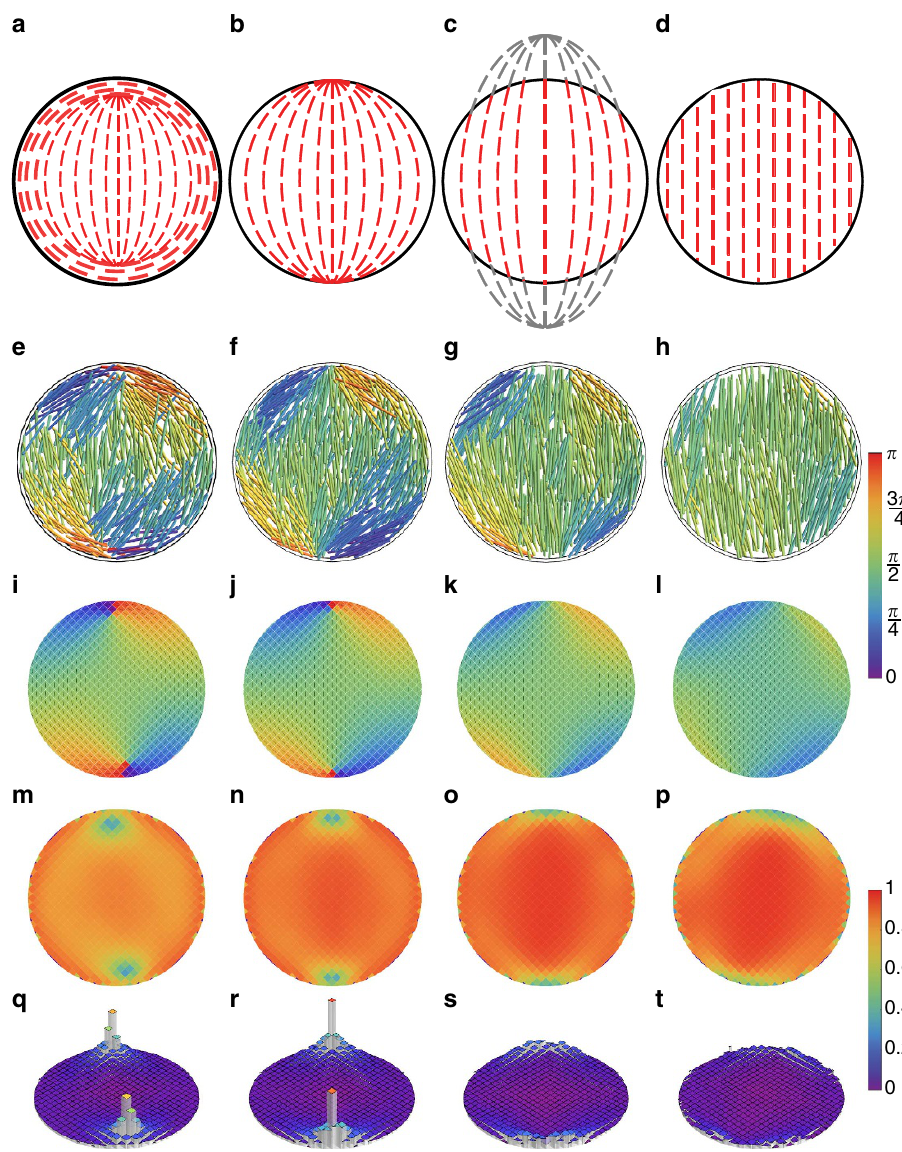
Figure 1 | Patterns of rod-like particles in circular confinement. Overview of packing structures of rod-like particles confined in shallow chambers with a circular geometry. Top row: schematic showing classification by the location of the disclination points: ( a ) type B i , ( b ) type B b , ( c ) type B o , ( d ) type B N . Second row: snapshots showing particle positions and their orientations with respect to the vertical (mod p ) (see colour bar on the right). Third row: orientation patterns averaged over 4 10 3 configurations. Fourth row: value of the scalar order parameter S A [0,1], scale bar on the right. For a discussion of the error estimate in this quantity see the Supplementary Note 8 and Supplementary Fig. 10 Note the characteristic dips at the location of the defects. Fifth row: normalized angular deficit parameter, which peaks at the centre of the defects. Simulation parameters: ( e , i , m , q ) L / D ¼ 15 and Z ¼ 0.16; ( f , j , n , r ) L / D ¼ 15 and Z ¼ 0.20; ( g , k , o , s ) L / D ¼ 20 and Z ¼ 0.20; ( h , l , p , t ) L / D ¼ 25 and Z ¼